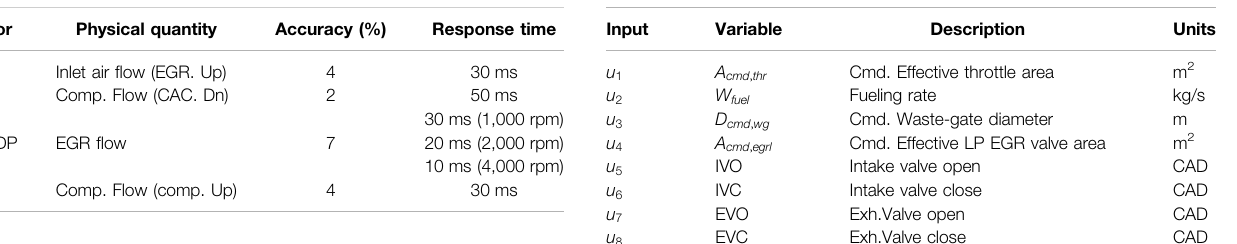
TABLE 3 | Input variables for the engine model.